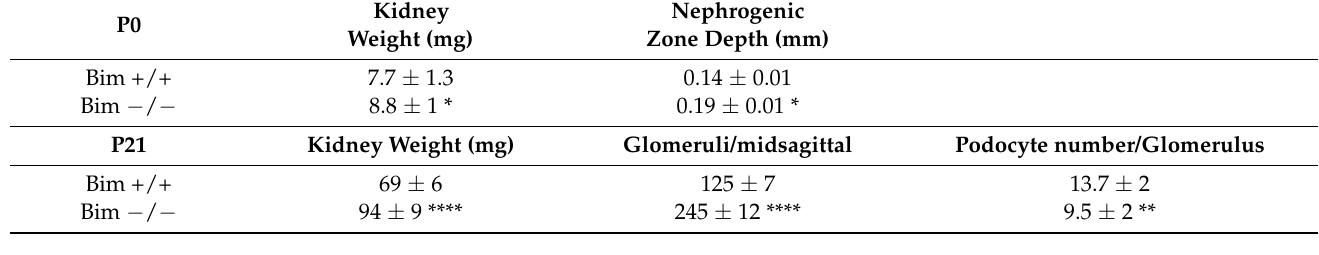
Table 1. Kidneys from Bim − / − mice have increased mass. Kidney weight (mg), mid-sagittal glomerular and podocyte numbers for postnatal day 21 (P21) mice, kidney weight, and nephrogenic zone depth (see Figure 3) are summarized for P0 mice. * p < 0.05, ** p < 0.01, and **** p < 0.0001.